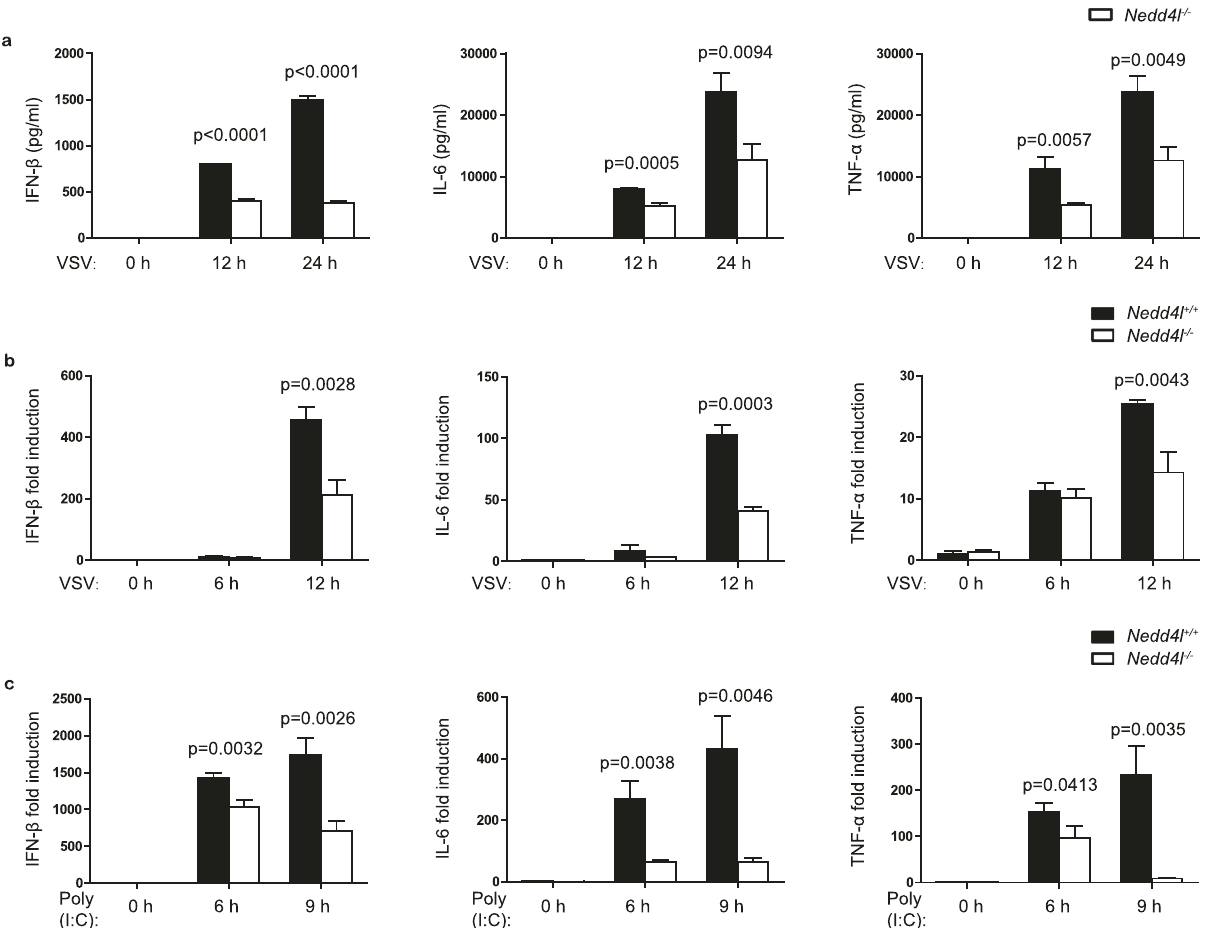
Fig. 1 Nedd4l de fi ciency inhibited antiviral innate immunity in macrophages. a ELISA assay of IFN- β , IL-6, and TNF- α production in wild-type ( Nedd4l + / + ) and Nedd4l-de fi cient homozygous ( Nedd4l − / − ) peritoneal macrophages infected with VSV (MOI = 10) for 12 and 24h. b RT-qPCR analysis of IFN- β , IL-6, and TNF- α mRNA expression in peritoneal macrophages in ( a ) infected with VSV (MOI = 10) for 6 and 12h. c RT-qPCR analysis of IFN- β , IL-6, and TNF- α mRNA expression in wild-type ( Nedd4l + / + ) and Nedd4l -/- peritoneal macrophages transfected with poly(I:C) (10 μ g/ml) for 6 and 9 h. Data in ( a – c ) are presented as mean± SD ( n = 3 per group) and p -values by two-tailed unpaired Student ’ s t -test are indicated. Results in ( a – c ) are representative of three independent